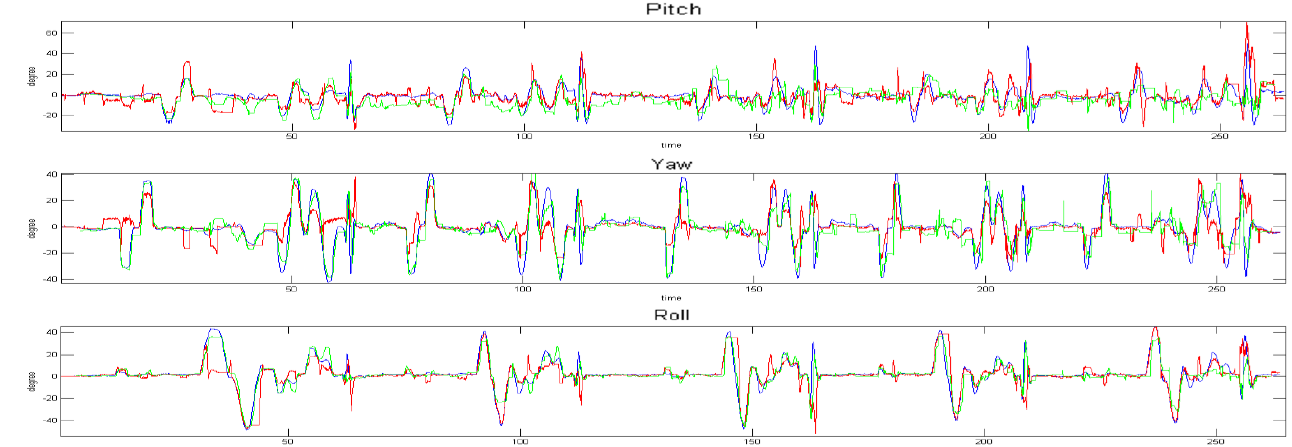
Figure 9. Reference: blue, KinectSDK: green, Facetracker: red. First row: pitch, second row: yaw, third row: roll.